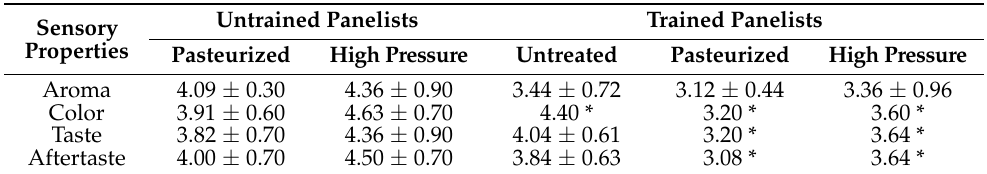
Table 7. Sensory analysis of three different milk samples (untreated, pasteurized, and high-pressure- treated) by untrained and trained panelists utilizing a hedonic scale (1 to 5, with 5 representing the greatest enjoyment) [65].